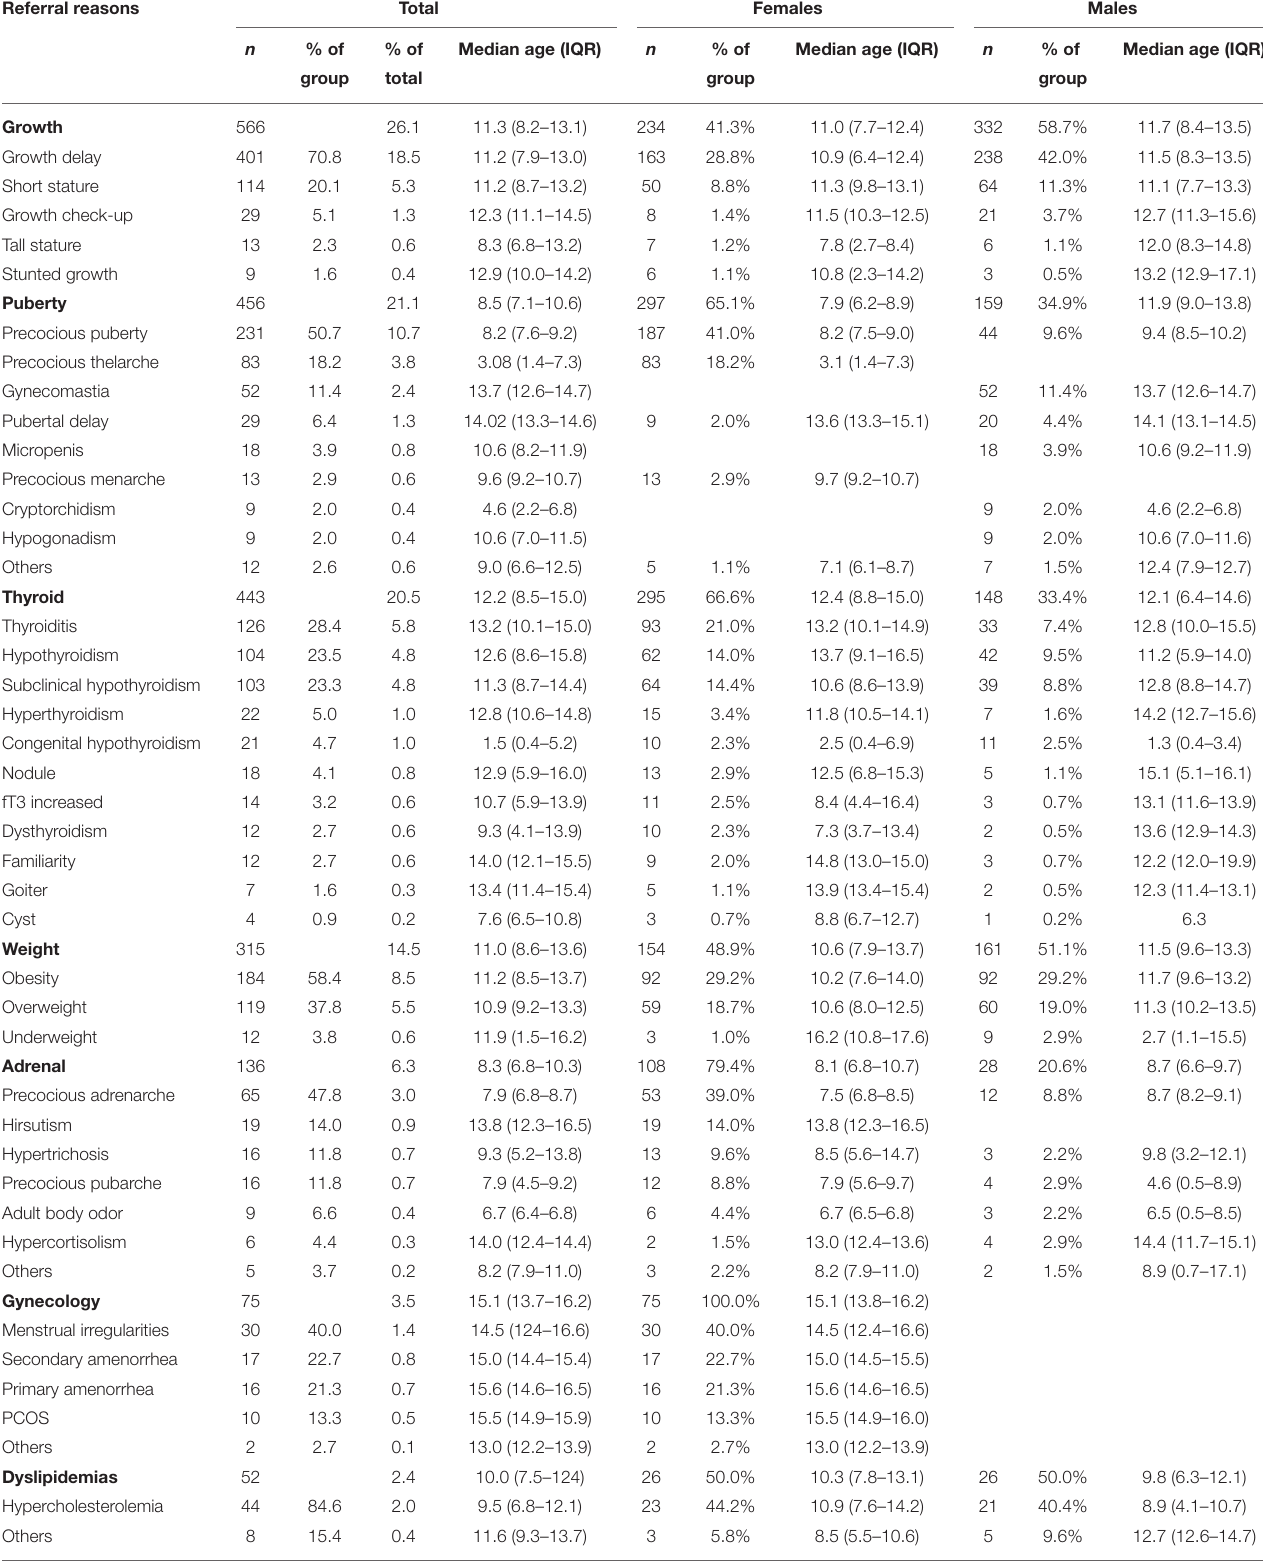
TABLE 1 | Distribution of referral reasons, divided in 12 cumulative groups in order of